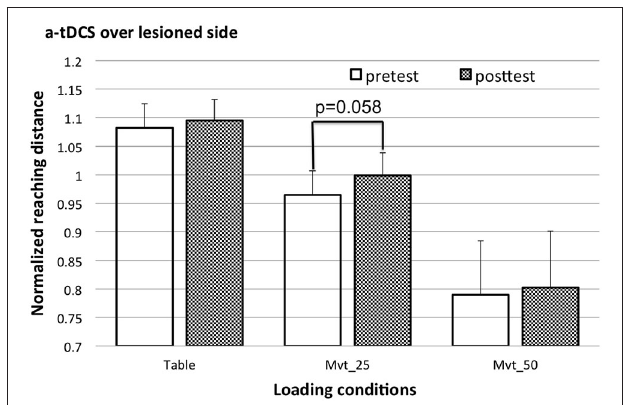
FIGURE 2 | Pre (gray) and post (blue) tDCS reaching trials for a-tDCS over the lesioned side with 25% of the MVT shoulder load (left) and c-tDCS over the non-lesioned side with 50% of